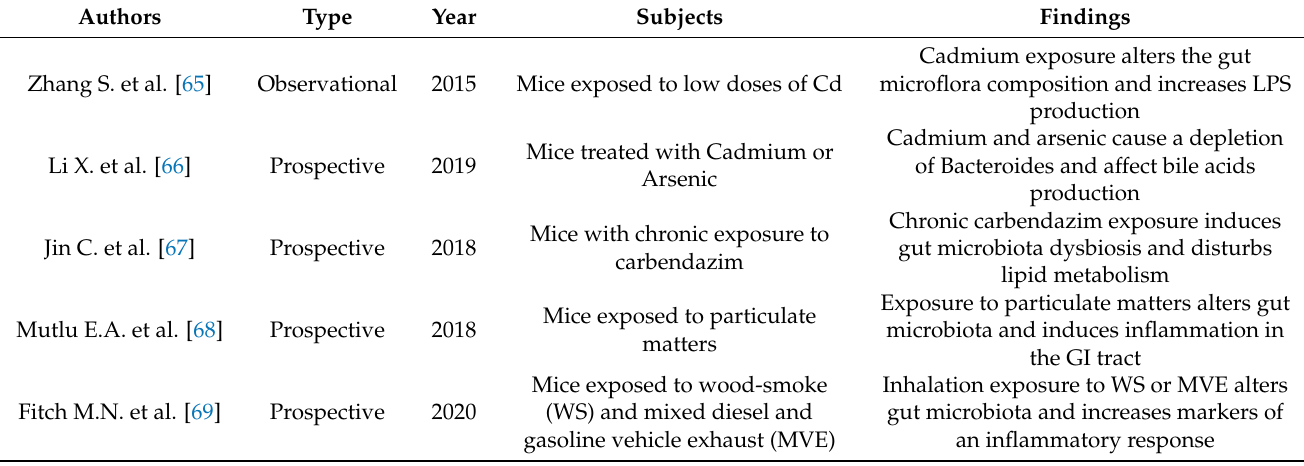
Table 5. Studies on the association between pollution, gut microbiota and cardiovascular disease.